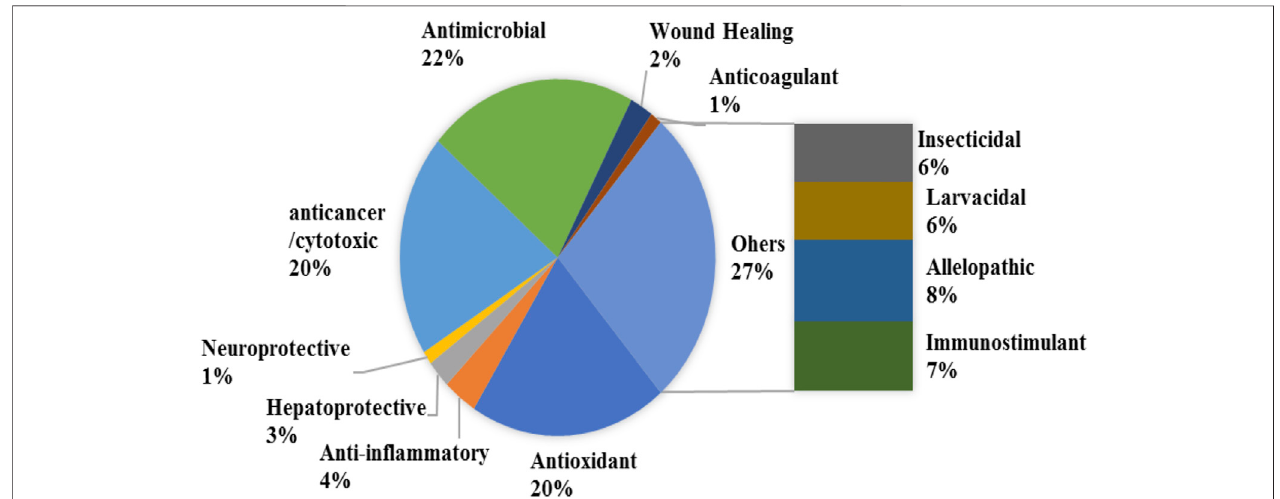
FIGURE 4 | Percentage of the studied biological and pharmacological activities of E. crassipes according to the literature.